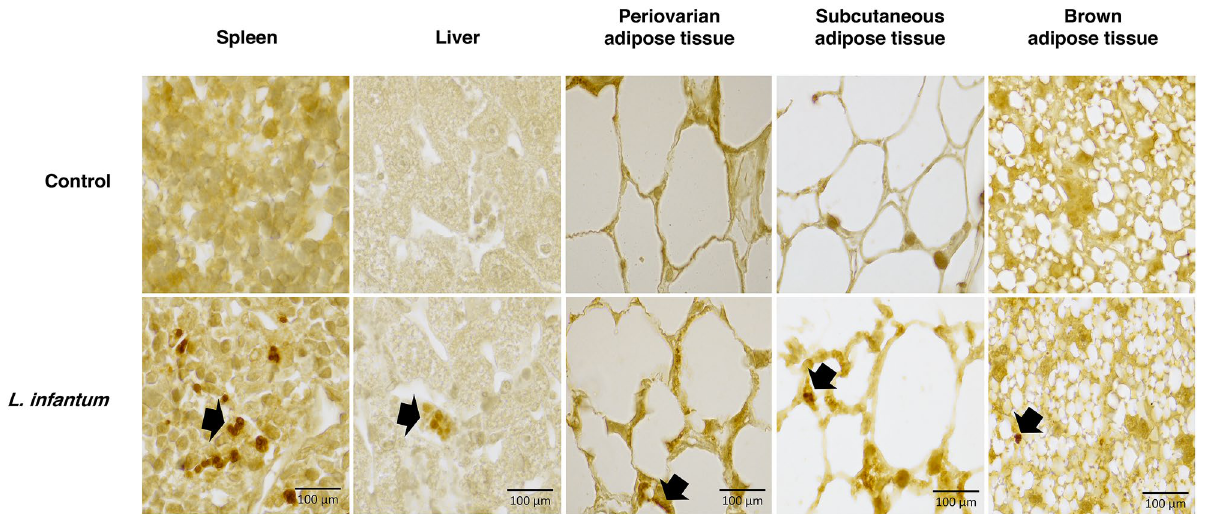
Figure 2. Immuno-labeled histological sections of tissues from BALB/c mice infected with Leishmania infantum , 40 weeks post infection. The presence of Leishmania infantum was determined in sections of different paraffin-embedded adipose tissue using rabbit anti- Leishmania polyclonal antibodies. Parasites were revealed using biotin-conjugated antibodies and peroxidase-labeled streptavidin. Labeled Leishmania infantum appear in orange/brown in adipocyte tissue (black arrows).